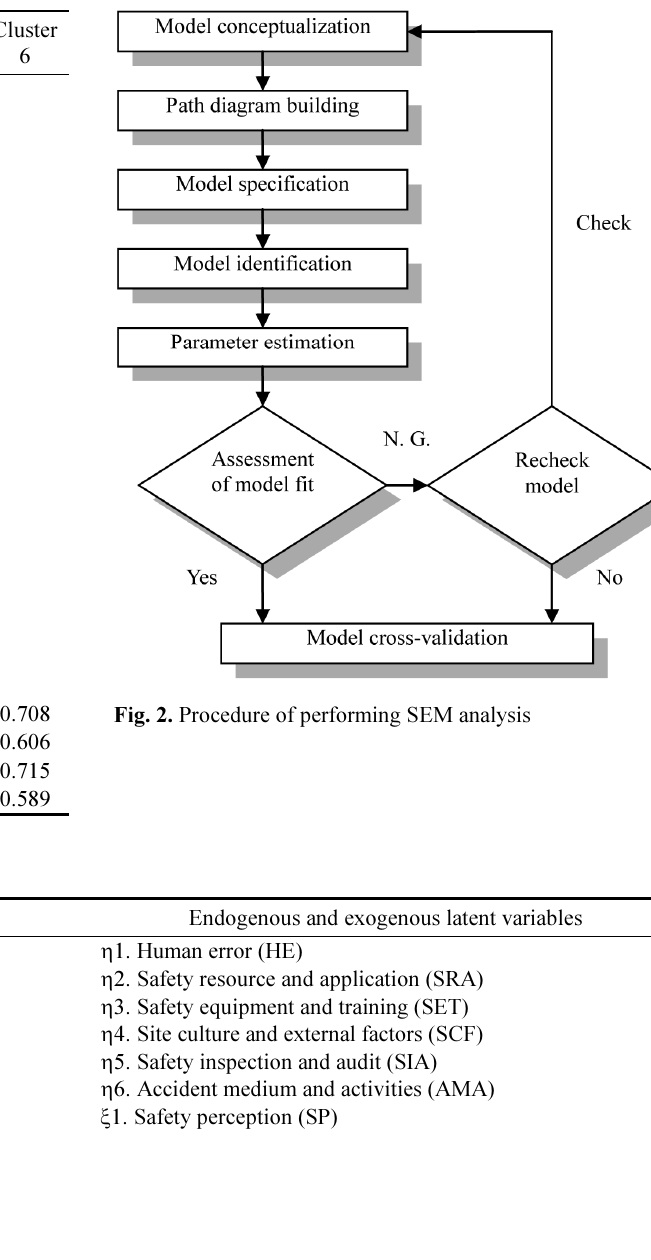
th stage analysis